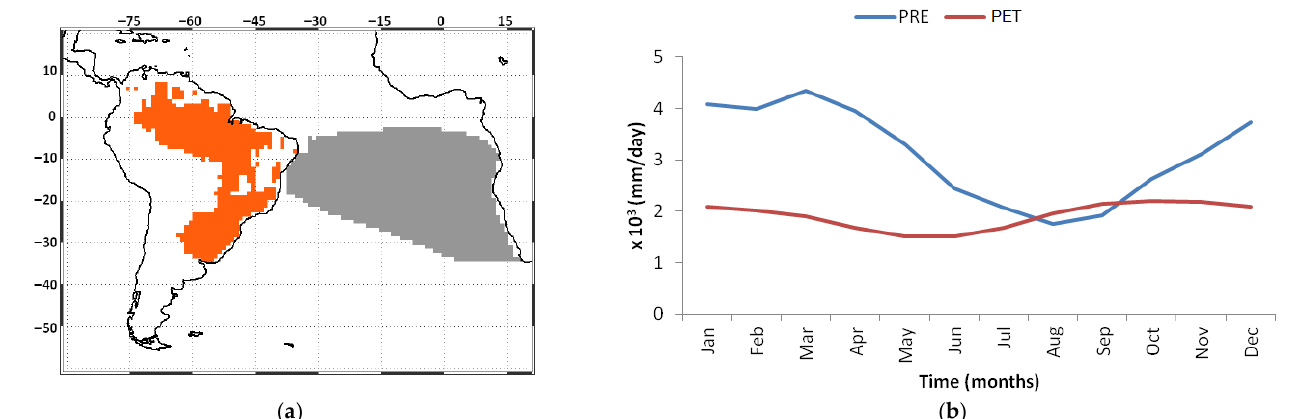
Figure 1. ( a ) In orange, the eastern South America (ESA) study region. ESA is a schematic representation of the annual sinks of moisture for the atmospheric particles that flow forward in time from the South Atlantic (SAT) source of moisture (in grey) for 10 days modeled by the FLEXPART model. The SAT is delimited based on the threshold of 750 mm/year for the annual climatological vertically integrated moisture flux (VIMF) divergence; ( b ) annual climatological precipitation cycle (PRE, blue line) and potential evapotranspiration (PET, red line) integrated over the ESA using data from the Climate Research Unit (CRU) Time-Series (TS) 4.03 database (scale in mm/day). Period of study: 1980 – 2018.